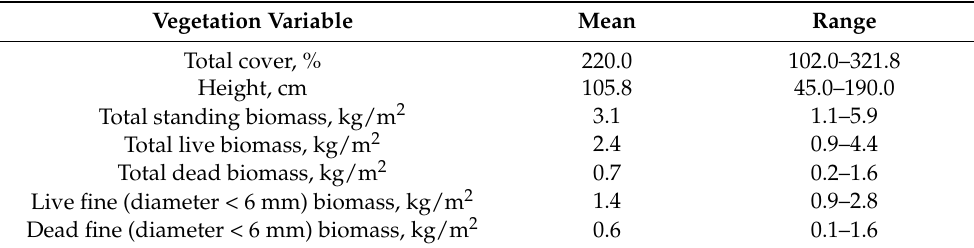
Table 4. Mean and range of variation of post-fire vegetation variables measured in the field plots.